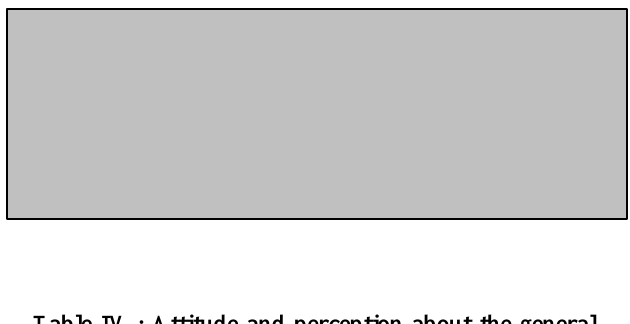
Table IV : Attitude and perception about the general